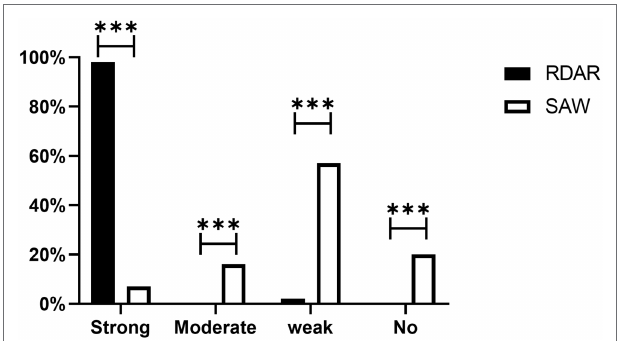
FIGURE 3 | Biofilm formation ability of different phenotype colonies. Strong, Strong biofilm formation ability; Moderate, Moderate biofilm formation ability; Weak, Weak biofilm formation ability; and No, none biofilm formation ability ( *** p < 0.001).